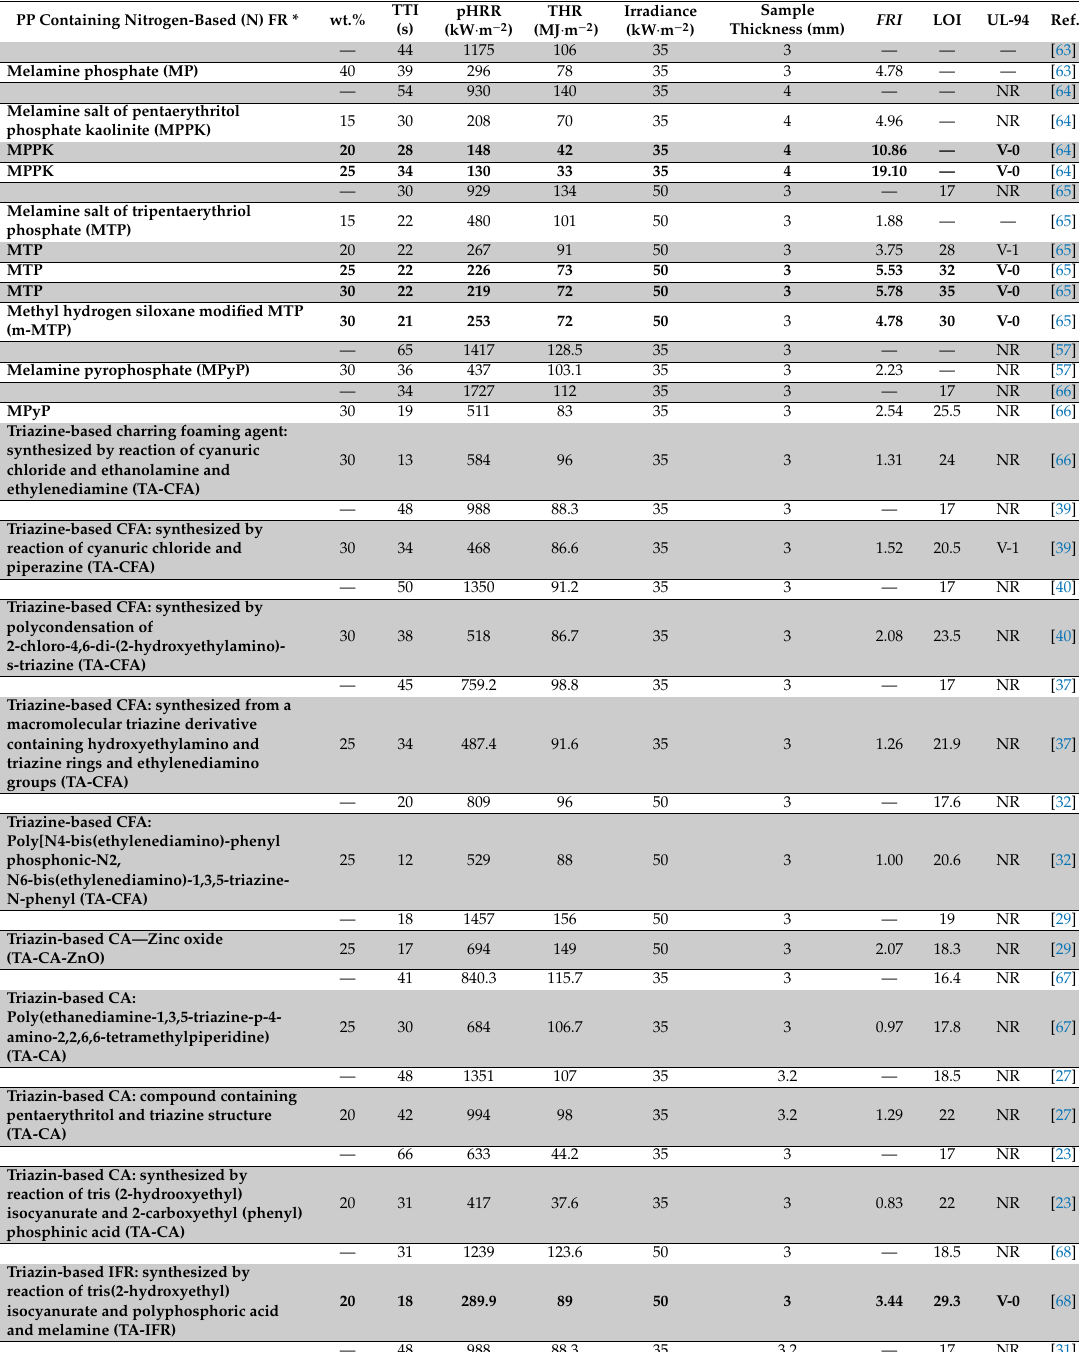
Table 2. Flame retardant PP materials containing nitrogen-based (N) flame retardants. Data are extracted from the literature: cone calorimetry parameters (TTI, pHRR, THR), LOI, and UL-94 values. The FRI values were calculated by authors of the present review. The name and the percentage of flame retardants are provided in separate columns. “wt.%” was used for loading level of additives, while “—” stands for the systems free of additive or the neat PP. * FR means flame retardant. Since all comparisons were made in terms of FRI , classification of polymers in terms of their flame-retardant properties was not surveyed based on the chemistry of additives, heat flux, sample thickness, etc. PP Containing Nitrogen-Based (N) FR